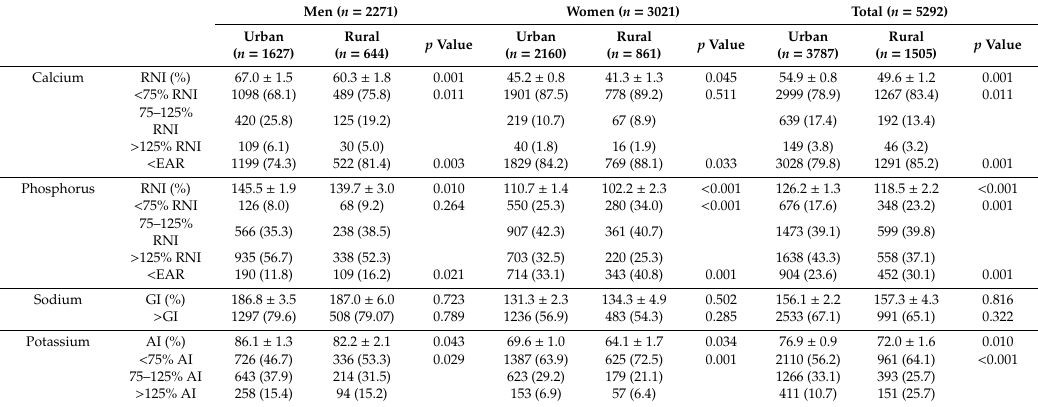
Table 4. Mineral intake levels by Dietary Reference Intakes (DRI) of rural and urban Korean